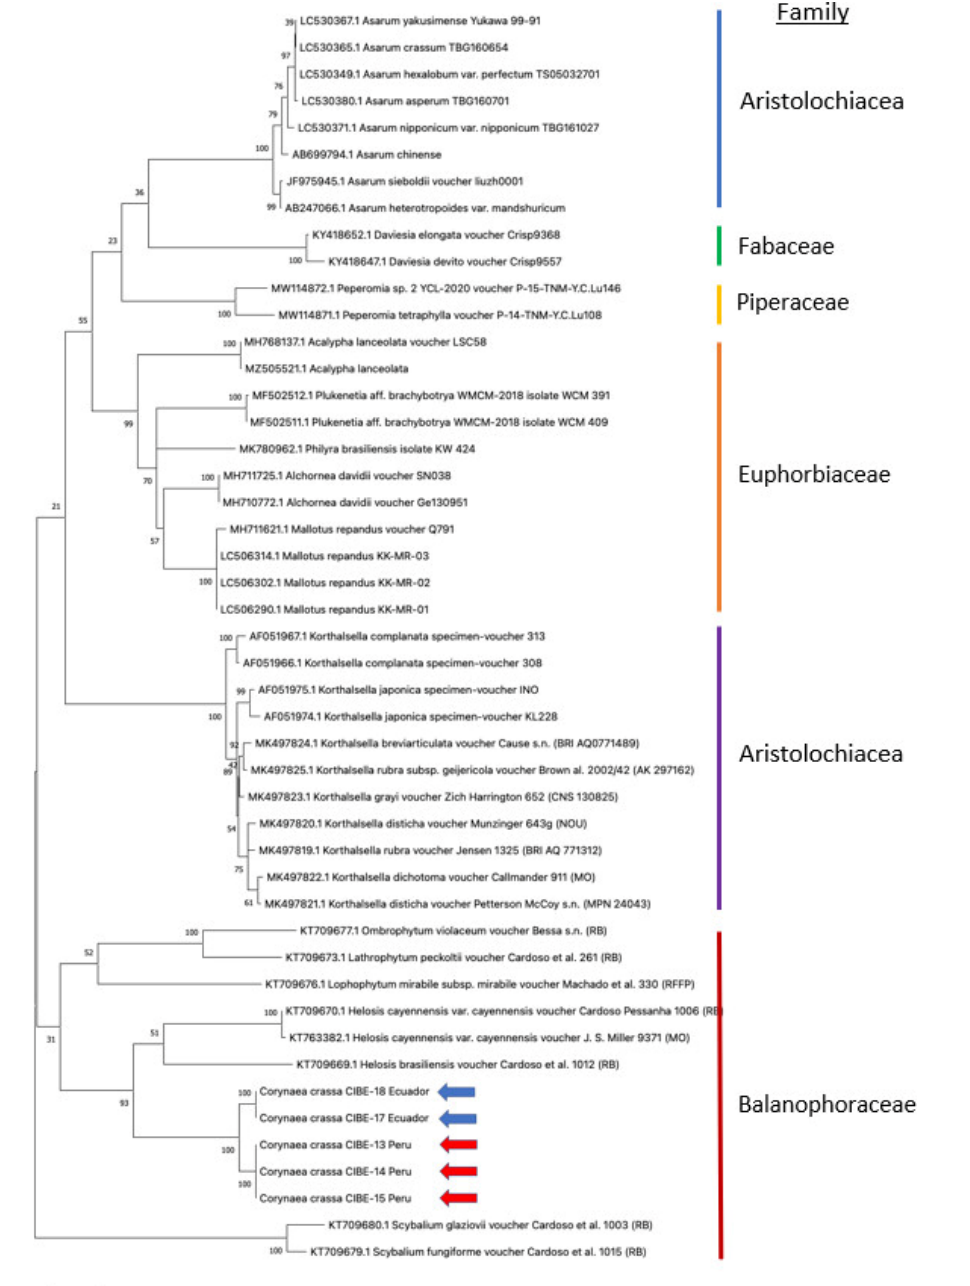
Figure 1. Phylogenetic analysis was performed by using the Maximum Likelihood method and Kimura 2 ‐ parameter model of the ITS1 sequences from the C. crassa from Ecuador and Peru, and from accessions queried in the GenBank database. The percentage of trees in which the associated taxa clustered together is shown next to the branches. A discrete Gamma distribution was used to model evolutionary rate differences among sites (5 categories (+ G , parameter = 1.7045)). The rate variation model allowed for some sites to be evolutionarily invariable ((+ I ), 19.64% sites). The tree is drawn to scale, with branch lengths measured in the number of substitutions per site. This analysis involved 47 nucleotide sequences. There was a total of 673 positions in the final dataset. Evolutionary analyses were conducted in MEGA X [15,19]. Blue and red arrows indicate C. crassa from Ecuador and from Peru, respectively.